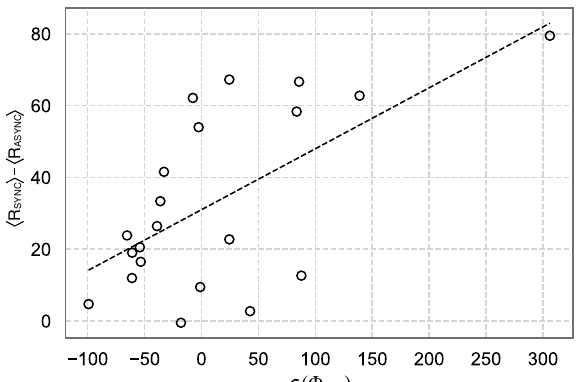
Figure 5. Relationship between the difference in mean subjective reports, � R SYNC � − � R ASYNC � , and s (� MIP ) (see Eq. 1) for each subject (Pearson’s correlation test: r = 0.56 , n = 21 , p < 0.005 ; see Table S6 for other parameter